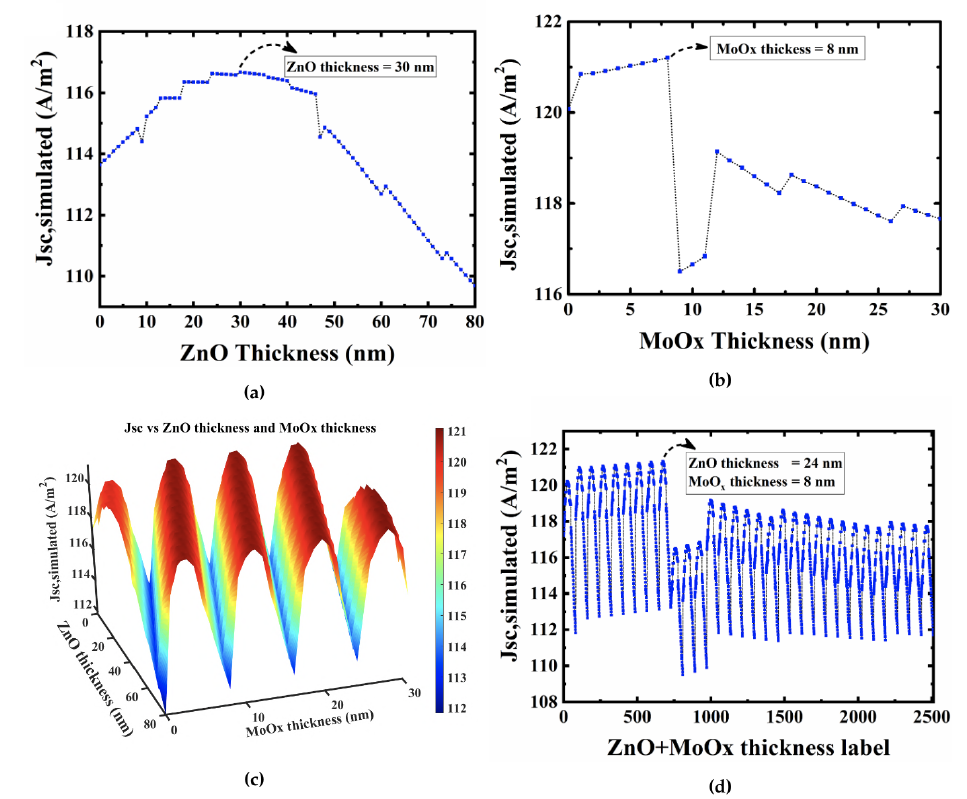
Figure 2. Brute-force method results: ( a ) single ZnO layer optimization, ( b ) single MoOx layer optimization, ( c ) multiple ZnO and MoOx layers optimization, ( d ) 2D data representation of ( c ) using labels pointing to the ZnO and MoOx layer thickness combinations for the ease of